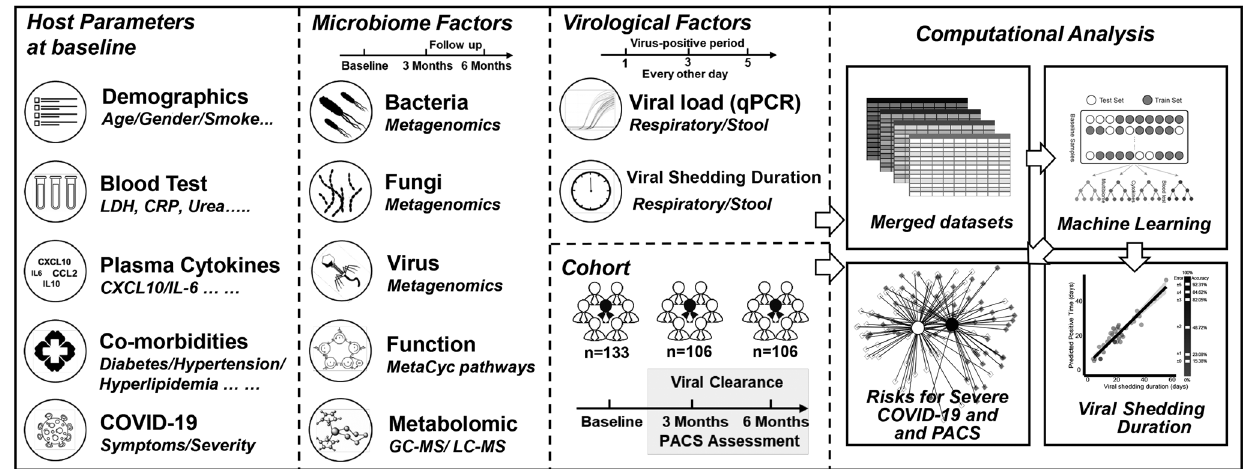
Fig. 1 | Schematicdiagram ofstudy design. Anintegratedapproach to investigate the prognosticrolesofmulti-kingdom microbiome, host parameters, and virological factors in COVID-19 outcomes and